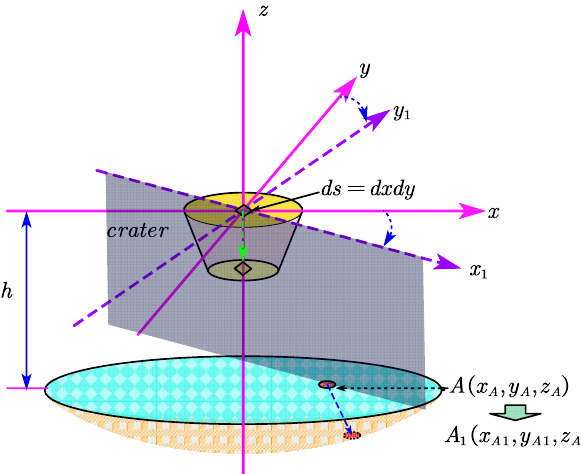
Figure 8. Dynamic compaction calculation model.